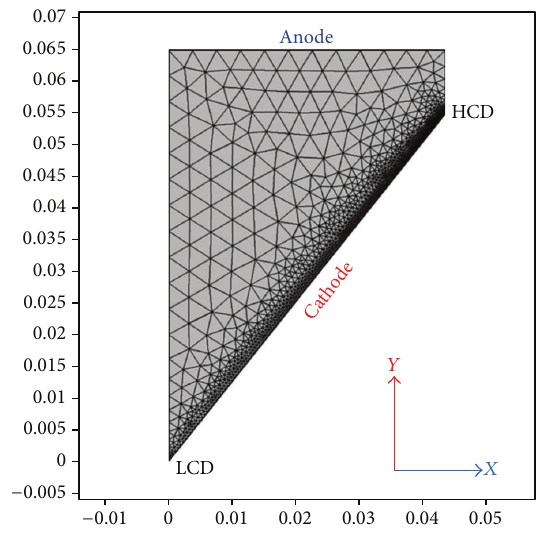
Figure 4: Meshing of the modified Hull cell.